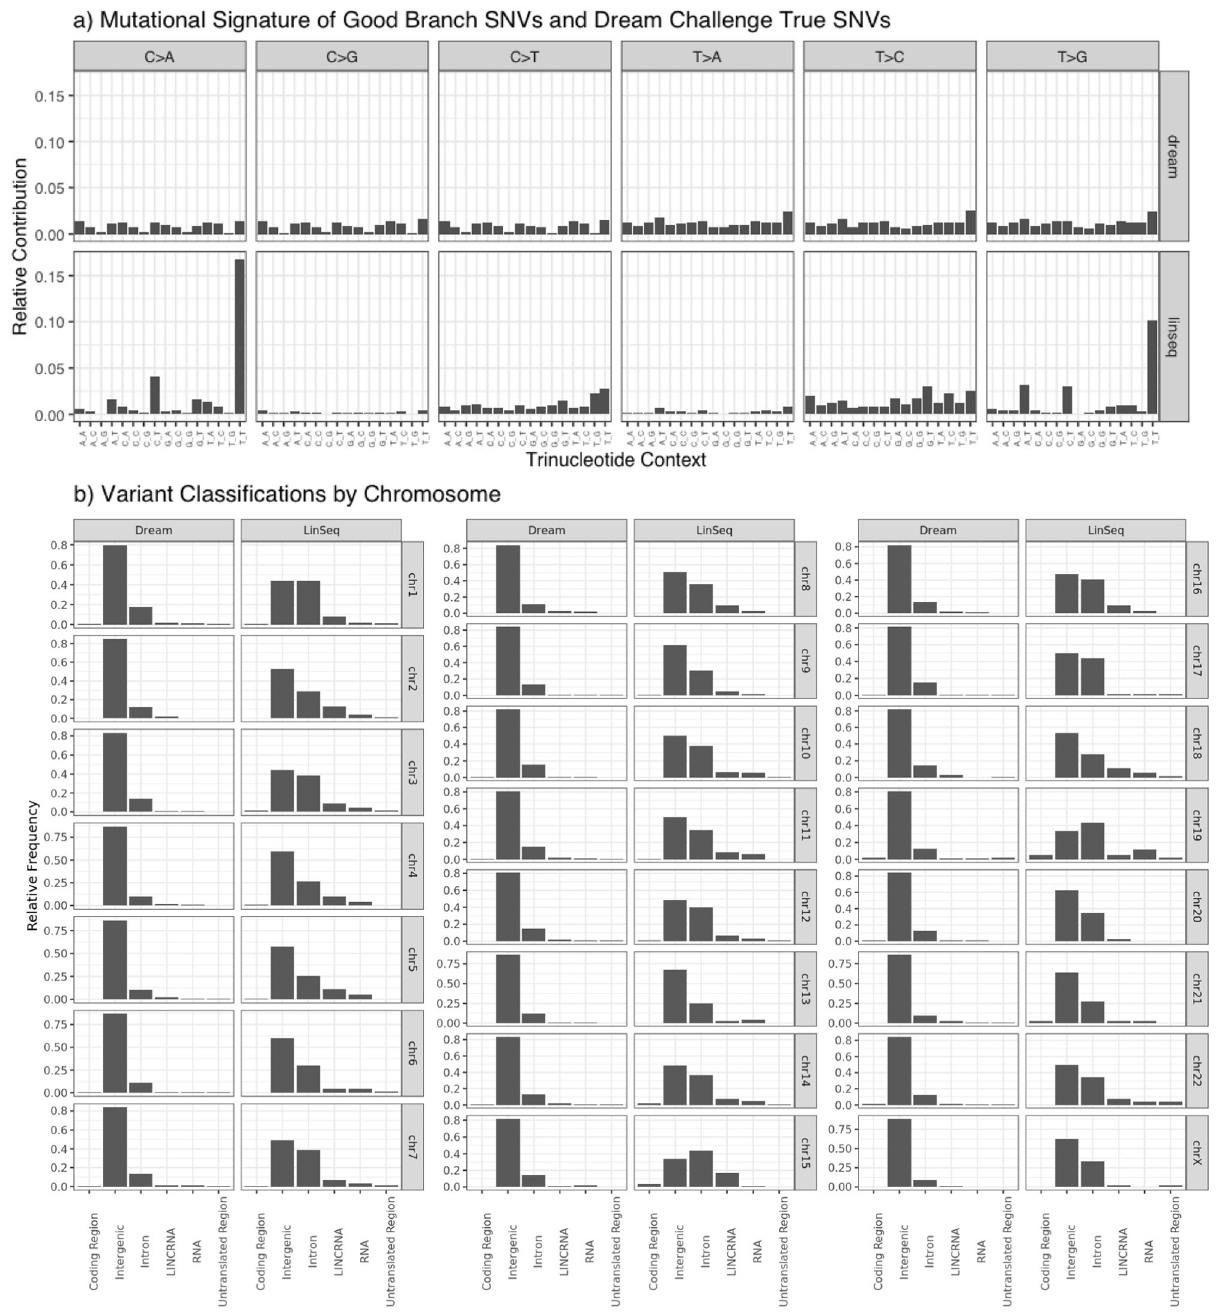
Fig. 4 Mutational signature and variant classi fi cation by chromosome of Good Branch Variants compared with ICGC-TCGA DREAM true sites. a Mutational Signature of the Good Branch Variants shows a distinct signature with high levels of C/A and T/G mutations. ICGC-TCGA DREAM true sites are uniform across various contexts. b Variant classi fi cations by chromosome, normalized by the number of bases in the reference in each category, show higher than expected proportion of intergenic sites in ICGC-TCGA DREAM than LinST. If each base in the genome was equally likely to be a true site in this plot, all bars would be the same